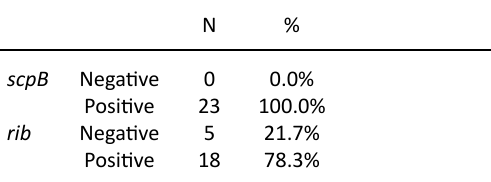
Table 6. scpB and Rib genes in positive GBS